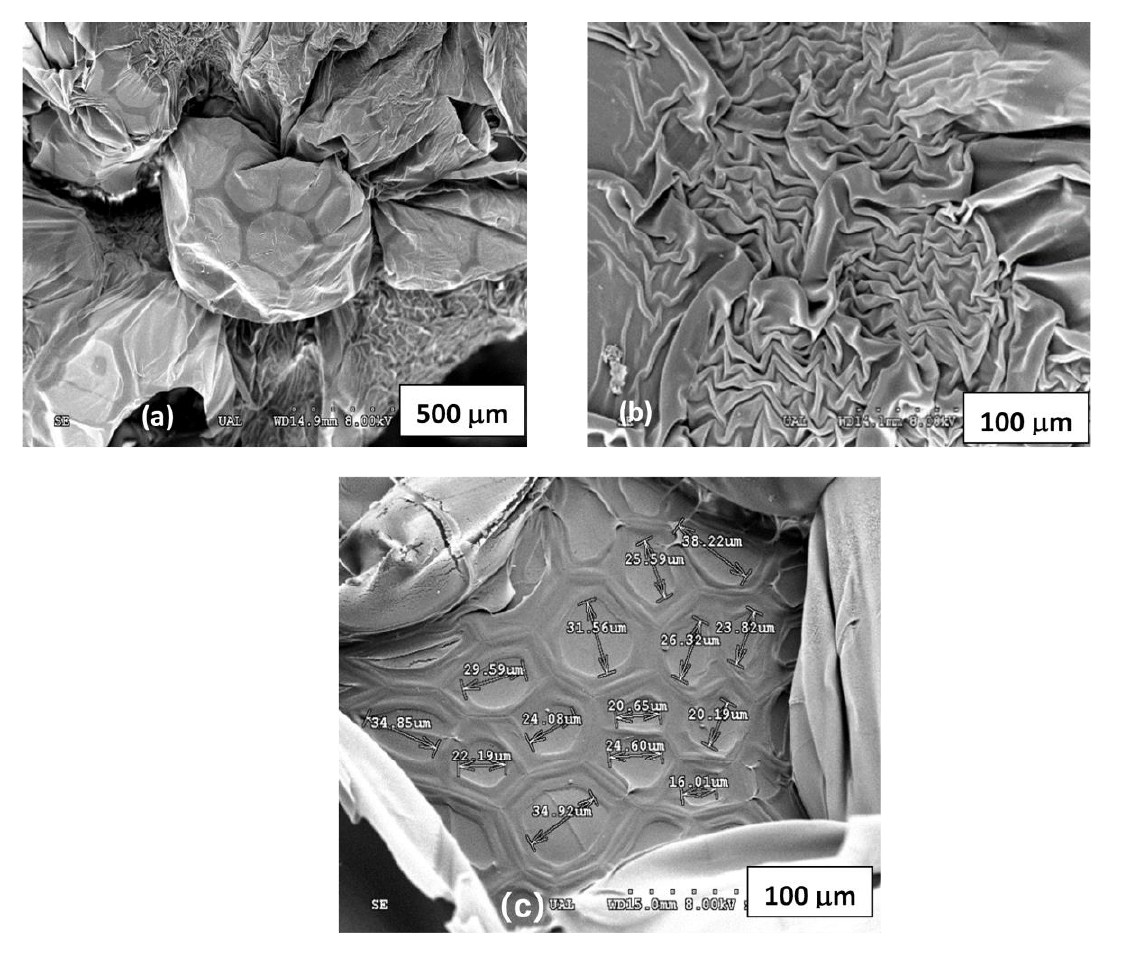
Figure 2. SEM images of H-NMBA system: ( a ) vesicles, ( b ) folds, and ( c ) marks of the interconnected cavities.